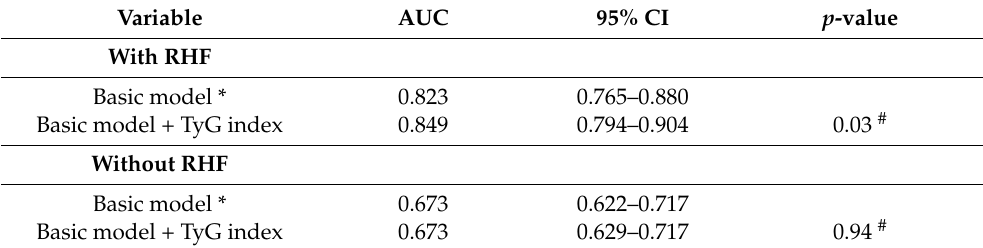
Table 6. Comparison of predictive power for the risk of albuminuria with TyG index with or without